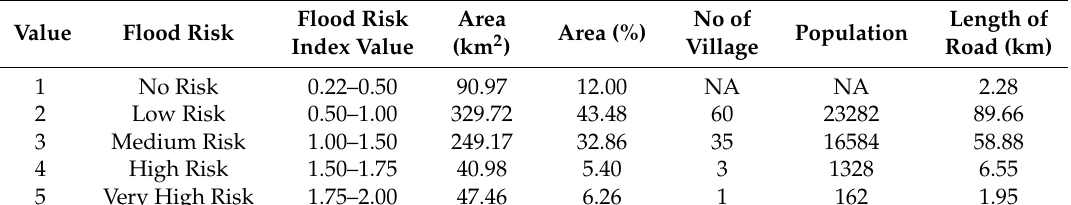
Table 5. Flood risk index and its impact based on MCDA for FRA mapping.